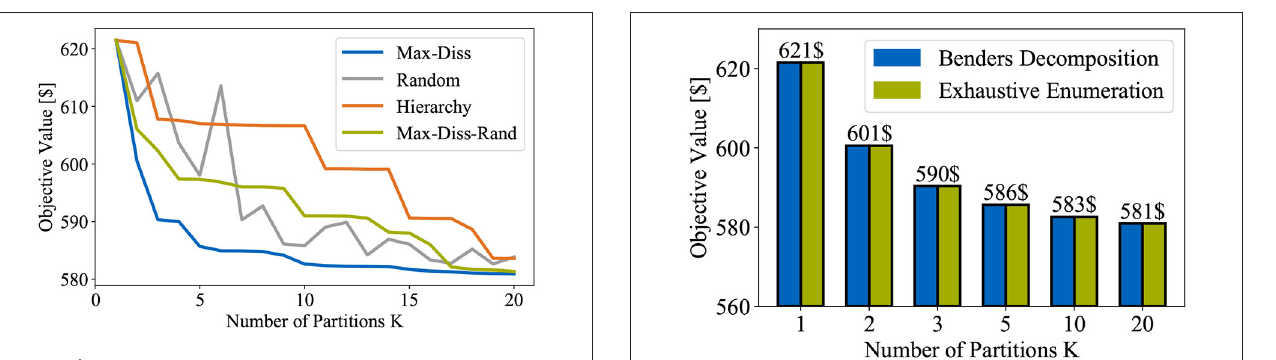
FIGURE 7 | Comparison of solutions to HUC for four different partitioning schemes. FIGURE 8 | Comparison of solutions to HUC after applying Benders decomposition and exhaustive